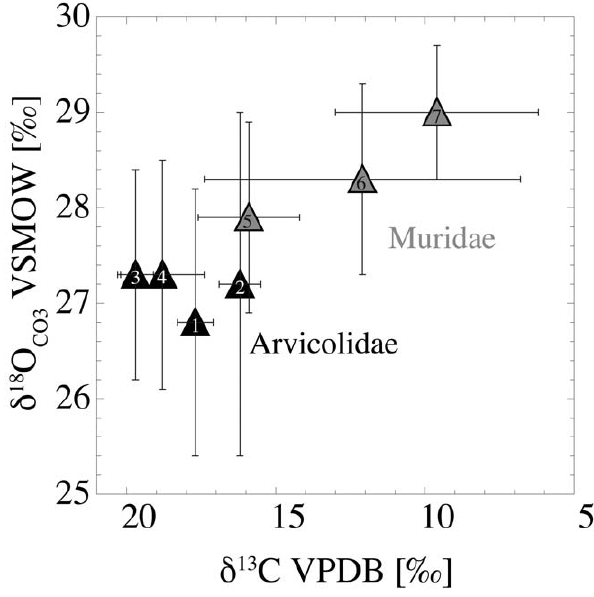
Figure 3. Mean d 18 O CO3 and d 13 C values of bulk incisors of the seven analysed rodent species (n=10 in each species) with 1 s error bars. 1: A . terrestris , 2: M . glareolus , 3: M . agrestis , 4: M . arvalis , 5: A . sylvaticus , 6: M . musculus , 7: R . norvegicus .